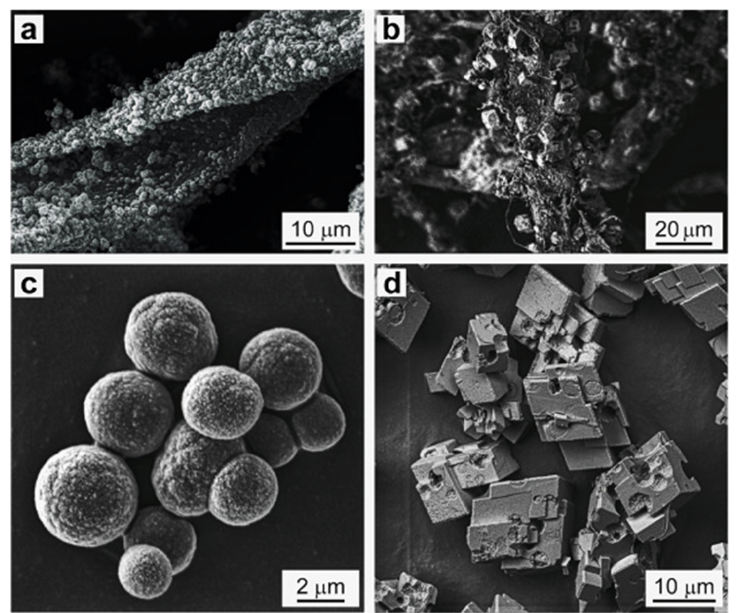
Figure 8. SEM images of CaCO 3 crystals formed on the MFC surface ( a , b ) and CaCO 3 crystals formed in the bulk solution ( c , d ). ( a , c ) MFC-CaCO 3 hybrids and CaCO 3 crystals were stored dry in the air for one week; ( b , d ) MFC-CaCO 3 hybrids and CaCO 3 crystals were incubated in water for one week. In all samples, CaCO 3 crystals were loaded with BSA TRITC via co-synthesis (C 0 is 0.33 mg mL − 1 ). This Figure was adapted with permission from [32].